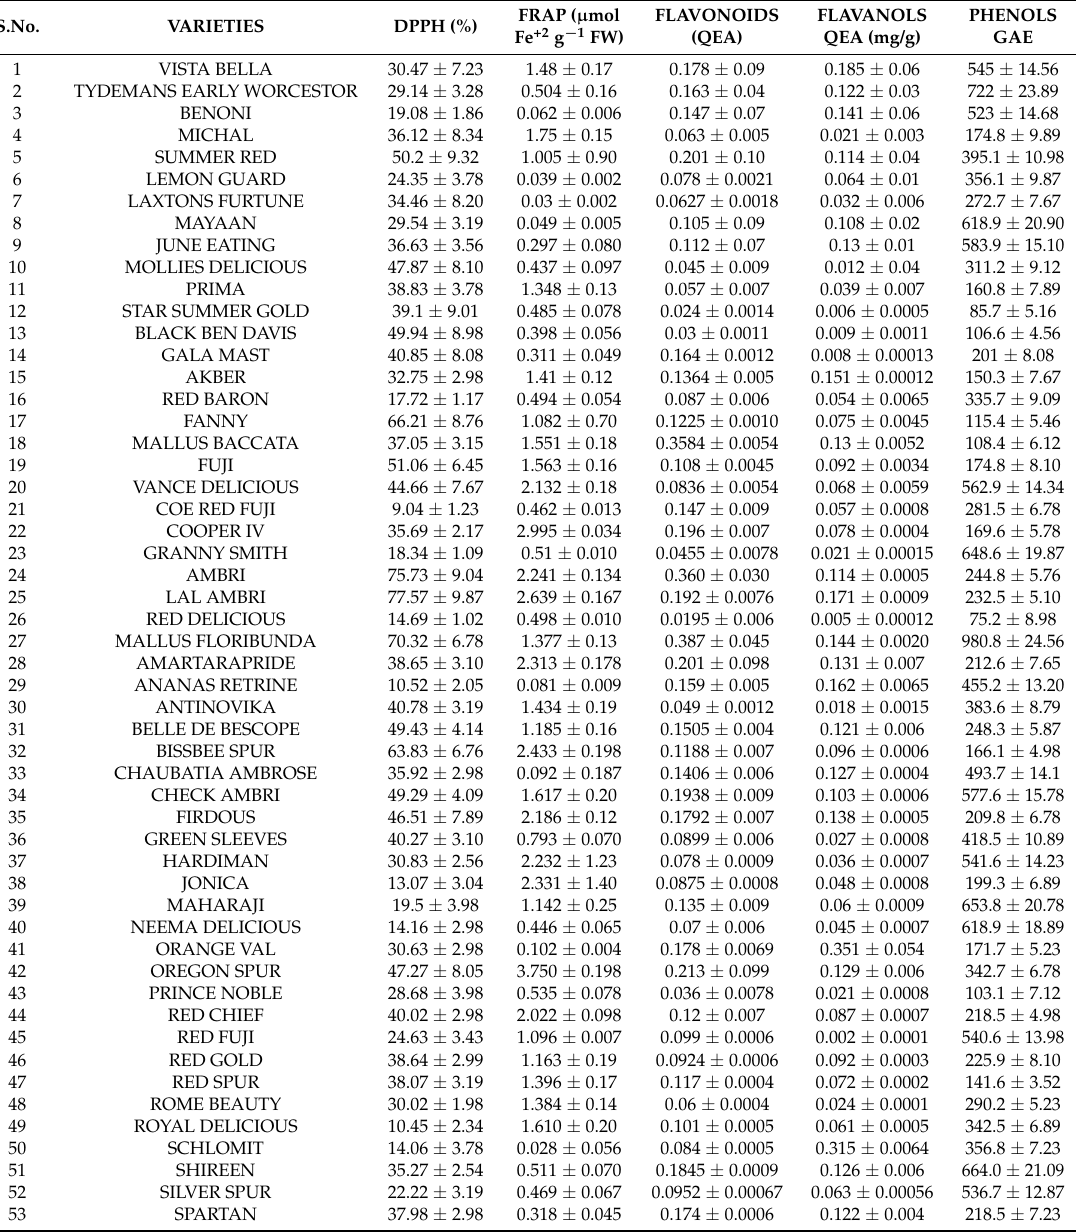
(Table 2). Catechins and rutin were the predominant bioactive compounds in all apple genotypes. The maximum catechin content (5290.47 ( µ g/g)) was observed in the apple genotype Malus floribunda followed by Ambri (2028.94), and the minimum catechin content (238.57 ( µ g/g)) was observed in Neema Delicious, while the maximum (483.89 ( µ g/g)) and minimum (12.13 ( µ g/g)) rutin contents were found in Lal Ambri and June Eating, respectively. Table 2. Variability in antioxidant efficacy of diverse apple genotypes. The data is represented in mean ± SD ( n = 10) and letter in the superscript symbolize the letters of significance with respect to each other using Tukey’